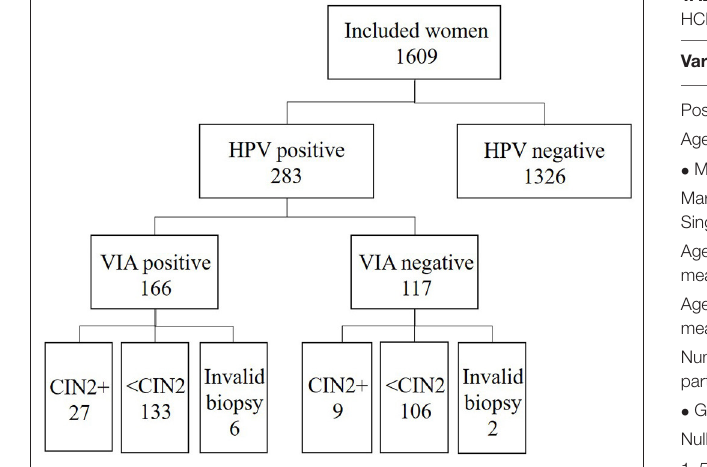
FIGURE 3 | Flowchart of the included population and screening results. HPV, human papillomavirus; VIA, visual inspection with acetic acid; CIN, cervical intraepithelial neoplasia.